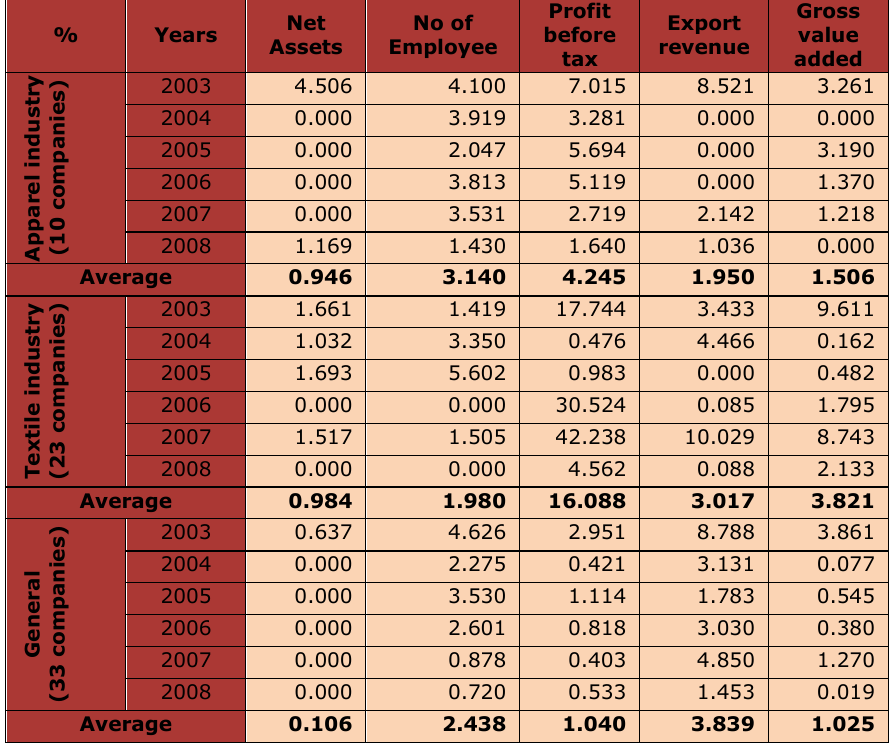
Table 3. The Total Percentage of Input Excesses and Output